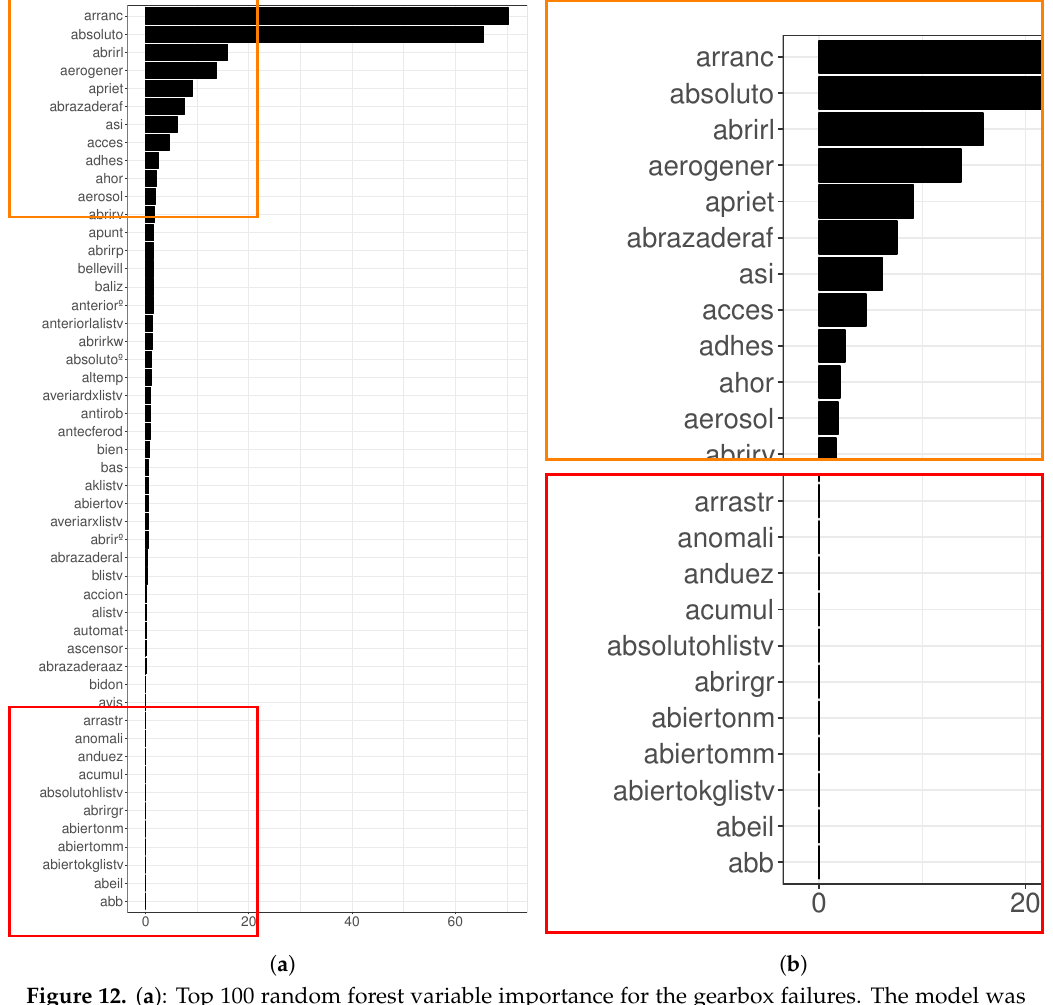
Figure 12. ( a ): Top 100 random forest variable importance for the gearbox failures. The model was generated with words that have a frequency from 1% to 50%. This range is a good trade-off according to the metrics of Figure 11. The top most and less frequent words can be seen in panel ( b ), delimited by an orange and a red square, respectively. The RF model selected the words arranc, which is the root of the word arrancar (to start), and absoluto (absolute), as the most important